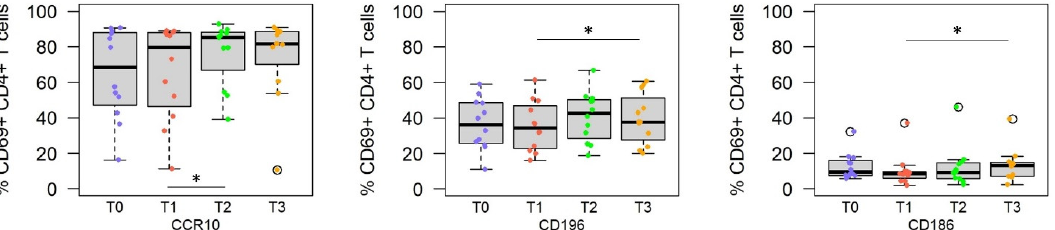
Figure 2. Homing receptor profile of SPZ-specific CD4 + T cells at different time points after vaccina-